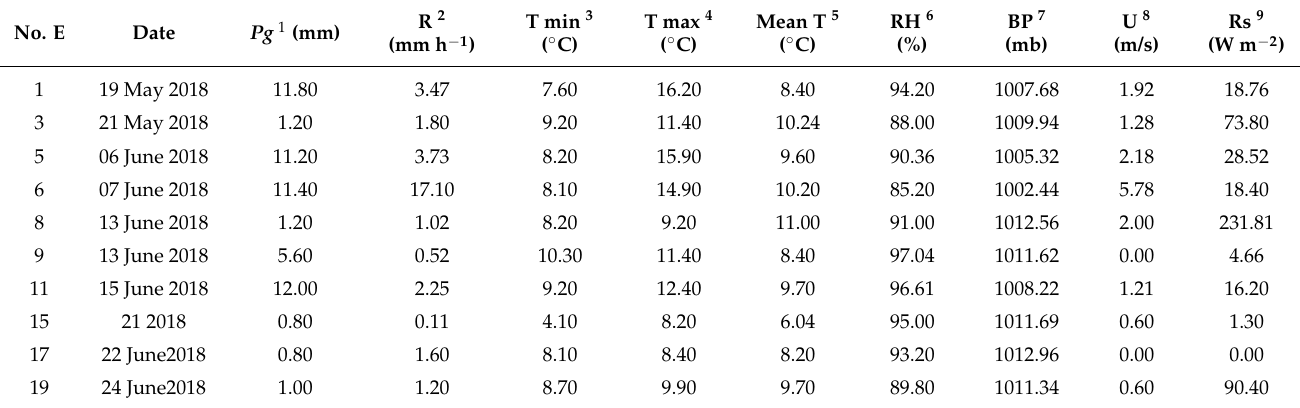
Table 5. Meteorological conditions of the group of precipitation events for the parametrization of the models. No.